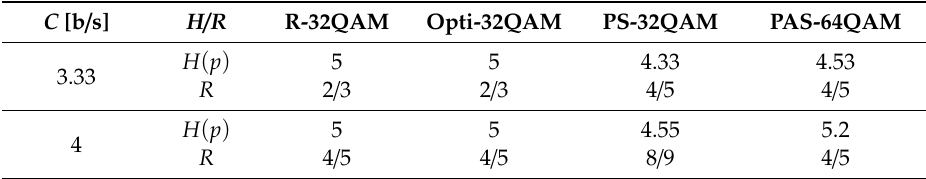
Table 1. The parameters used in the post-forward error correction (FEC) bit error rate (BER) analysis under the same capacity.